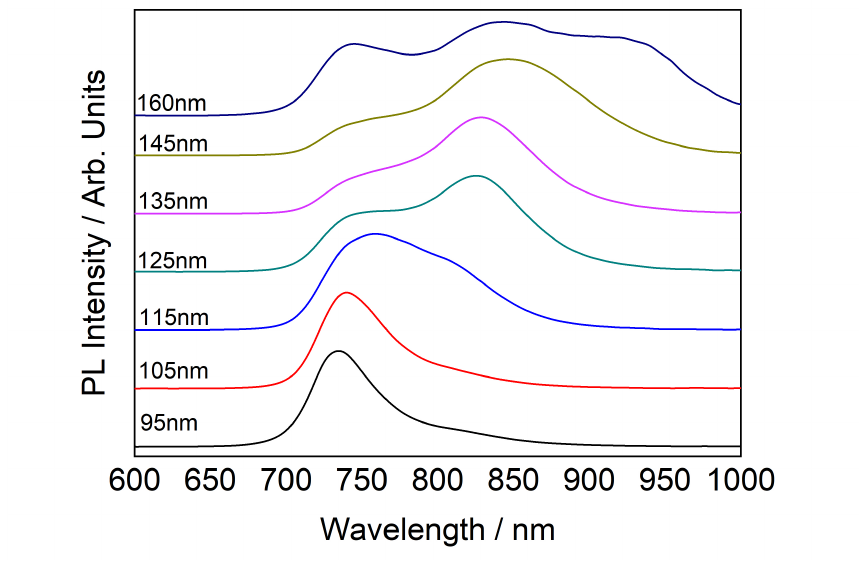
Figure 6. Evolution of PL spectrum with cavity